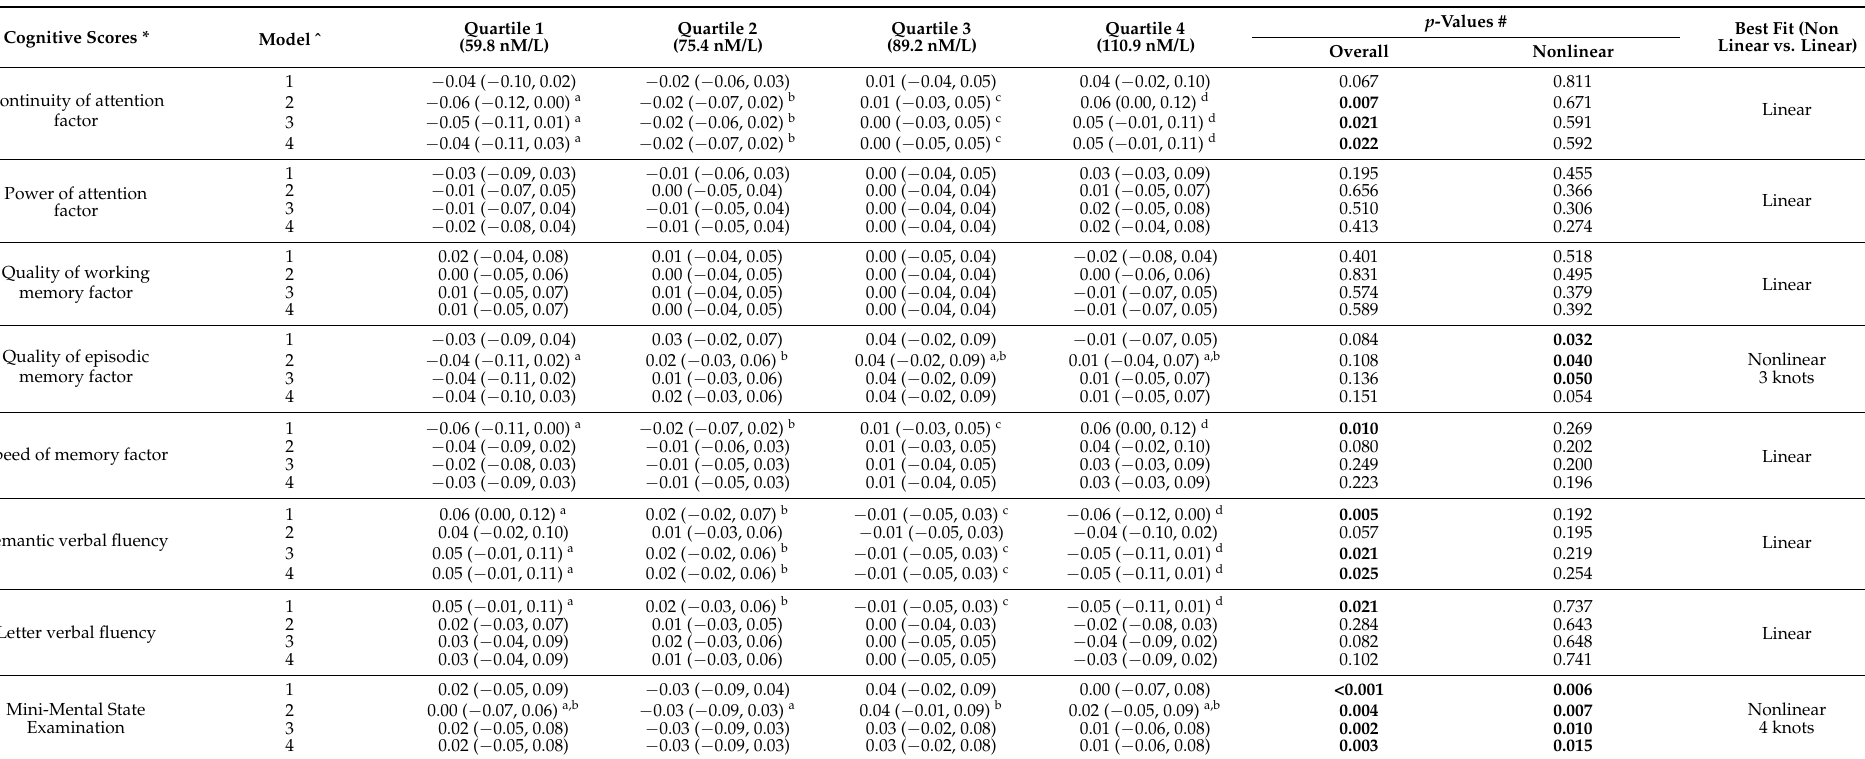
Table 3. Cognitive z -scores (least square means and 95% confidence limits) at mid-quartile levels of serum 25OHD in BHAS men derived from ‘best fit’